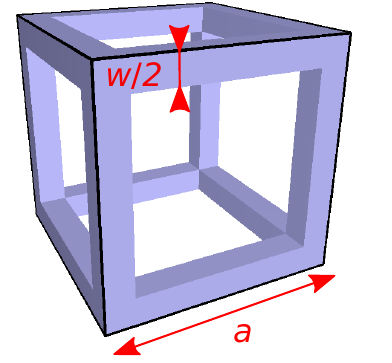
Figure 2. Unit cell of a simple cubic lattice composed of wire cubes assembled side by side (Dul’nev model). In the 3D-lattice, the width of the cube edges is w